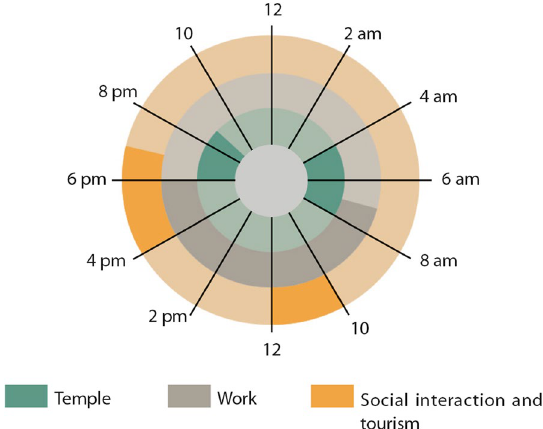
Fig. 8 Day circle showing the activities of the community in a typical day (Source: the author)